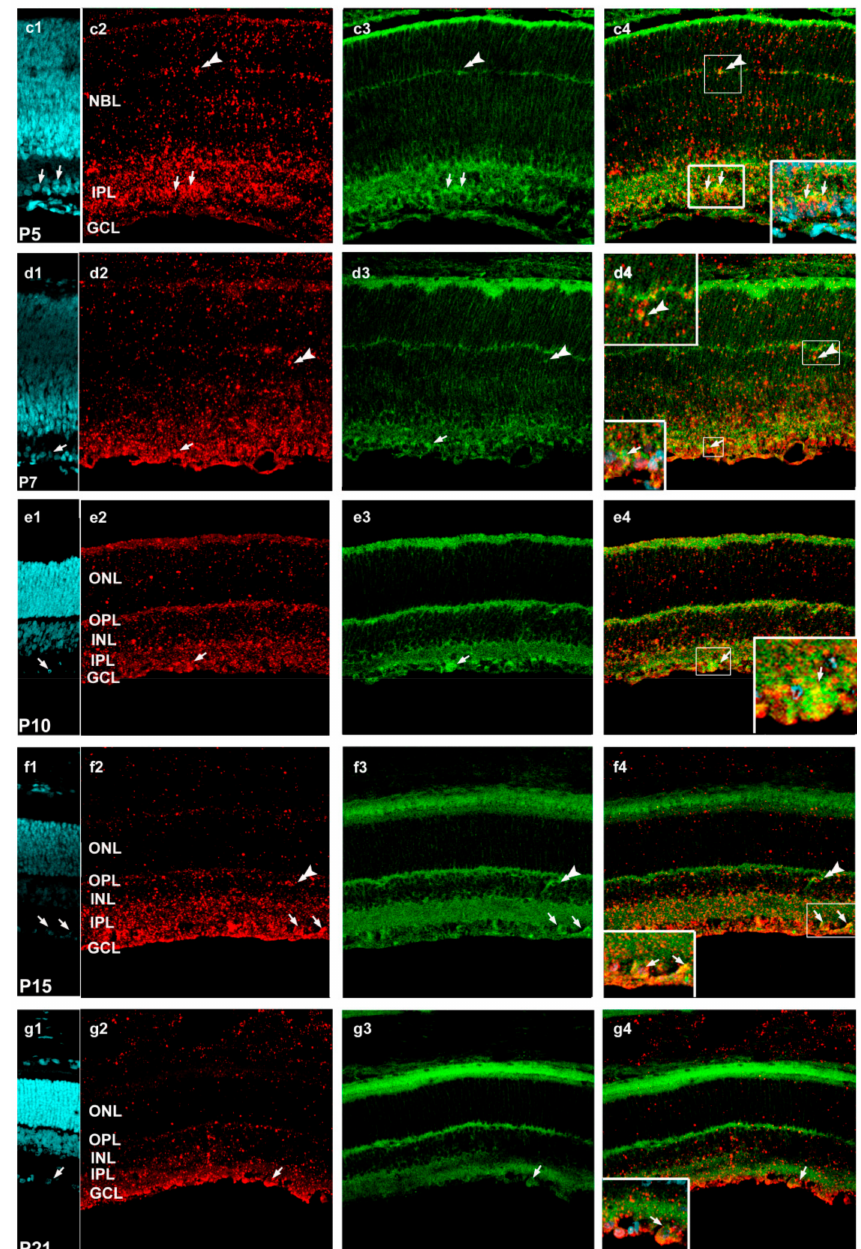
Figure 8. Characterization of miR-9-expressing (red: TSA Cy3) cells (in situ hybridization) and synaptotagmin-17 (green: Alexa Fluor-488) by immunolabeling in postnatal developing retina sections at the indicated ages (( a 1– a 4) P1; ( b 1– b 4) P3; ( c 1– c 4) P5; ( d 1– d 4) P7; ( e 1– e 4) P10; ( f 1– f 4) P15; ( g 1– g 4) P21). The first column demonstrates the DAPI staining, the second column shows mir-9 and the third column represents synaptotagmin-17 staining. The fourth column demonstrates the merged images of ISH–IHC staining. Arrows indicate ganglion cells and horizontal cells are demonstrated by double arrowheads. The scale bar seen in Panel a2 represents 50 µ m. NBL, neuroblast layer; GCL, ganglion cell layer; IPL, inner plexiform layer; INL, inner nuclear layer; OPL, outer plexiform layer; ONL, outer nuclear